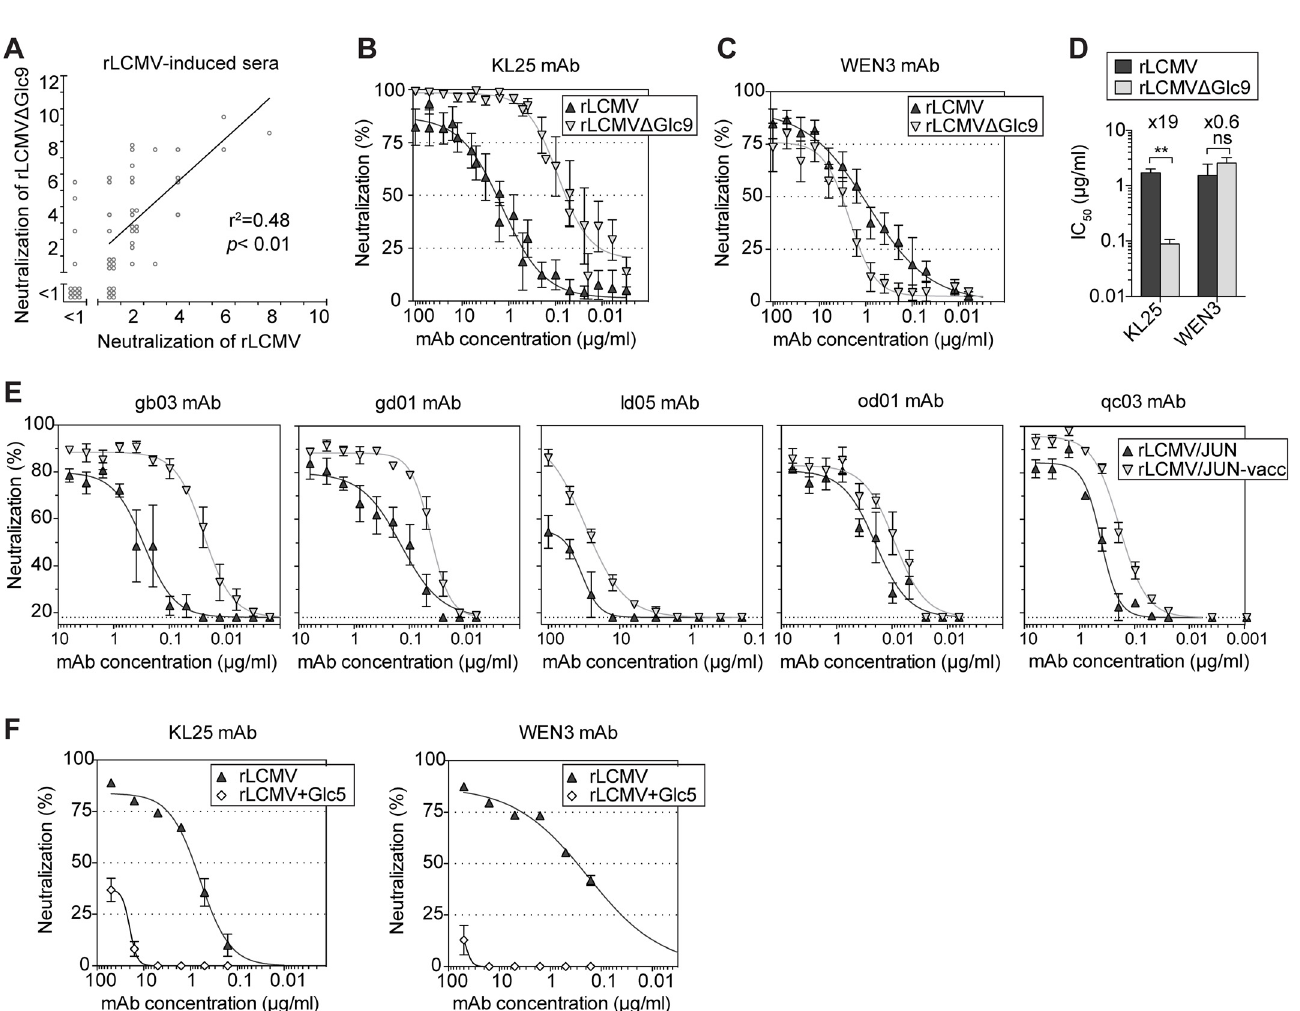
Fig 4. Monoclonal Abs neutralize preferentially GP-1 variants that lack specific glycans. (A) We infected C57BL/6 mice with rLCMV (10 5 − 10 6 PFU) and collected serum after virus clearance (day 40 – 80). We assessed neutralizing activity against the immunizing rLCMV and against the partially deglycosylated variant rLCMV Δ Glc9. Each point represents an individual mouse serum sample. Data from 53 mice in nine independent experiments are summarized. The Pearson ’ s correlation coefficient and two-tailed p -value are indicated. ** p < 0.01. (B-D) We quantified the neutralization potency of KL25 and WEN3 mAbs against rLCMV (wt GP) and rLCMV Δ Glc9, respectively (B-C), and determined half-maximal inhibitory concentrations (IC 50 , D). The mean ± SEM of 7 data points recorded in 5 independent experiments is represented. Unpaired student ’ s t-tests were used for statistics. ** p < 0.01. (E) The neutralization potency